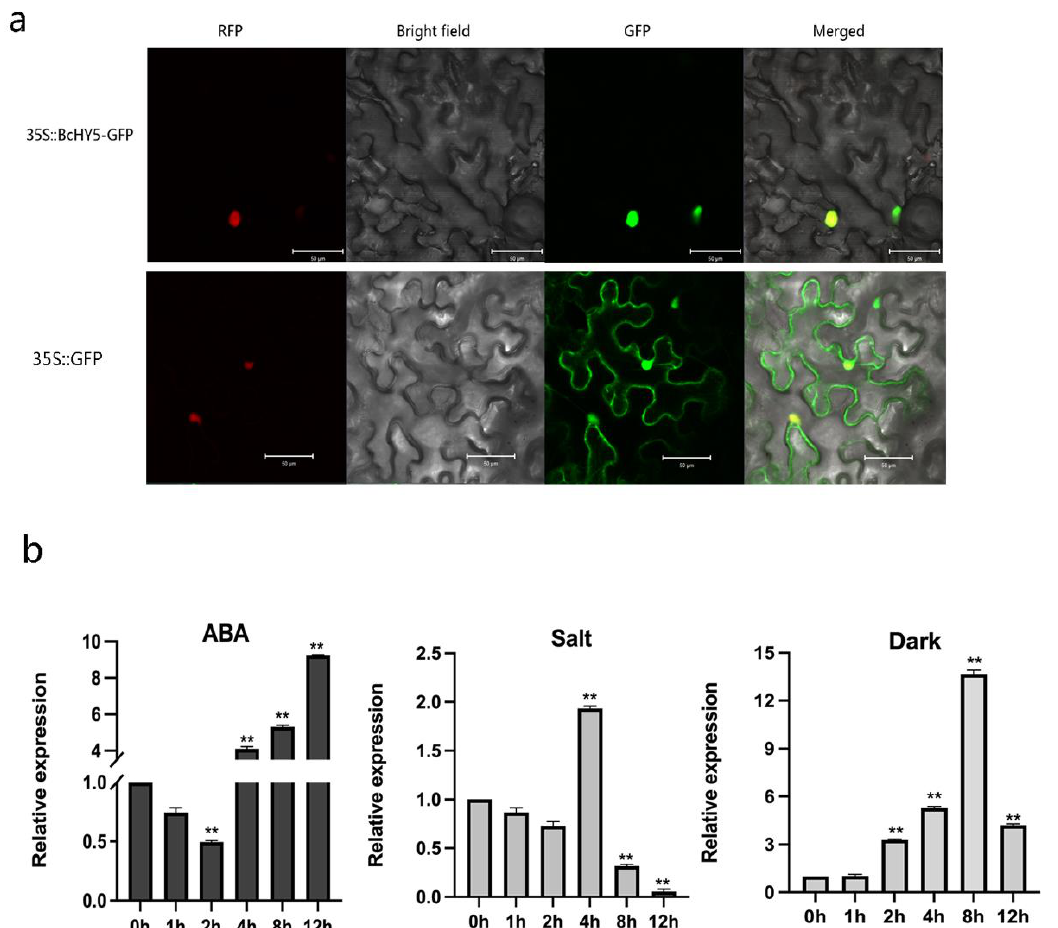
Figure 2. Subcellular localization of BcHY5 and expression patterns of BcHY5 in NHCC. ( a ) Subcellular localization of BcHY5. Histone H2B-RFP fusion protein was used as the nuclear marker. Scale bars = 50 μm. ( b ) Expression patterns of BcHY5 gene in NHCC. Error bars represent the standard deviation among independent replicates. Asterisks (** p < 0.01, Student’s t -test) indicate statistical significance.